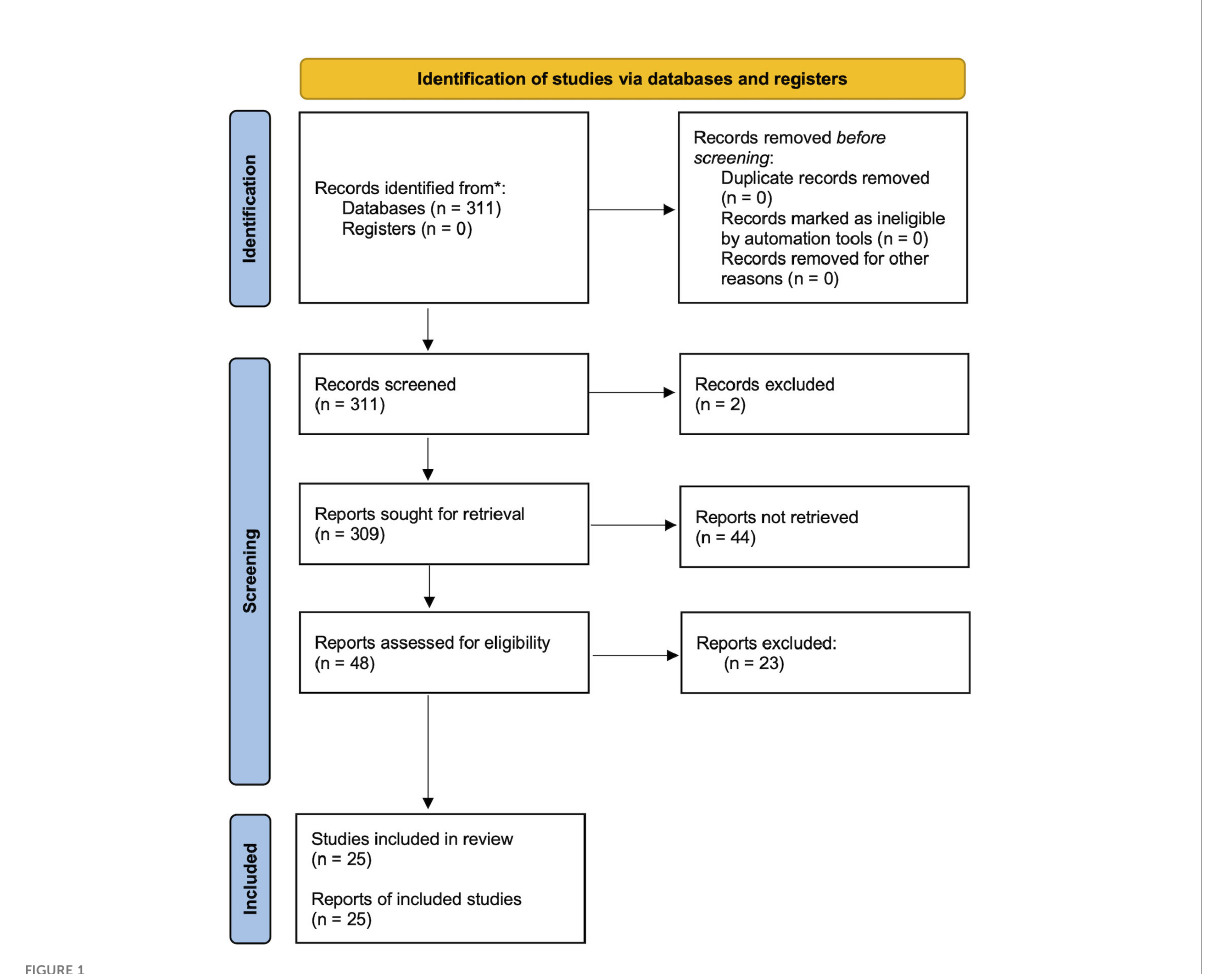
FIGURE 1 Overview of the screening